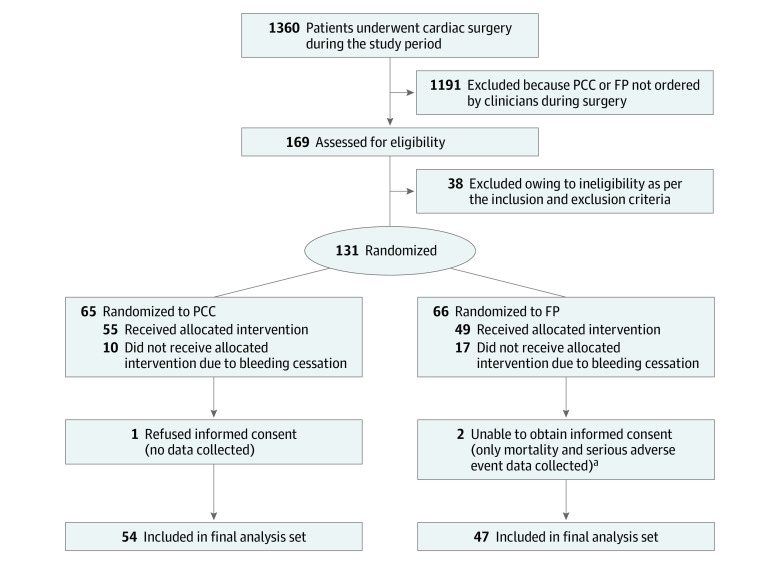
Enrollment, Randomization, and Treatment of Study PopulationFP indicates frozen plasma; PCC, prothrombin complex concentrate.aPermission granted a priori by the research ethics boards.